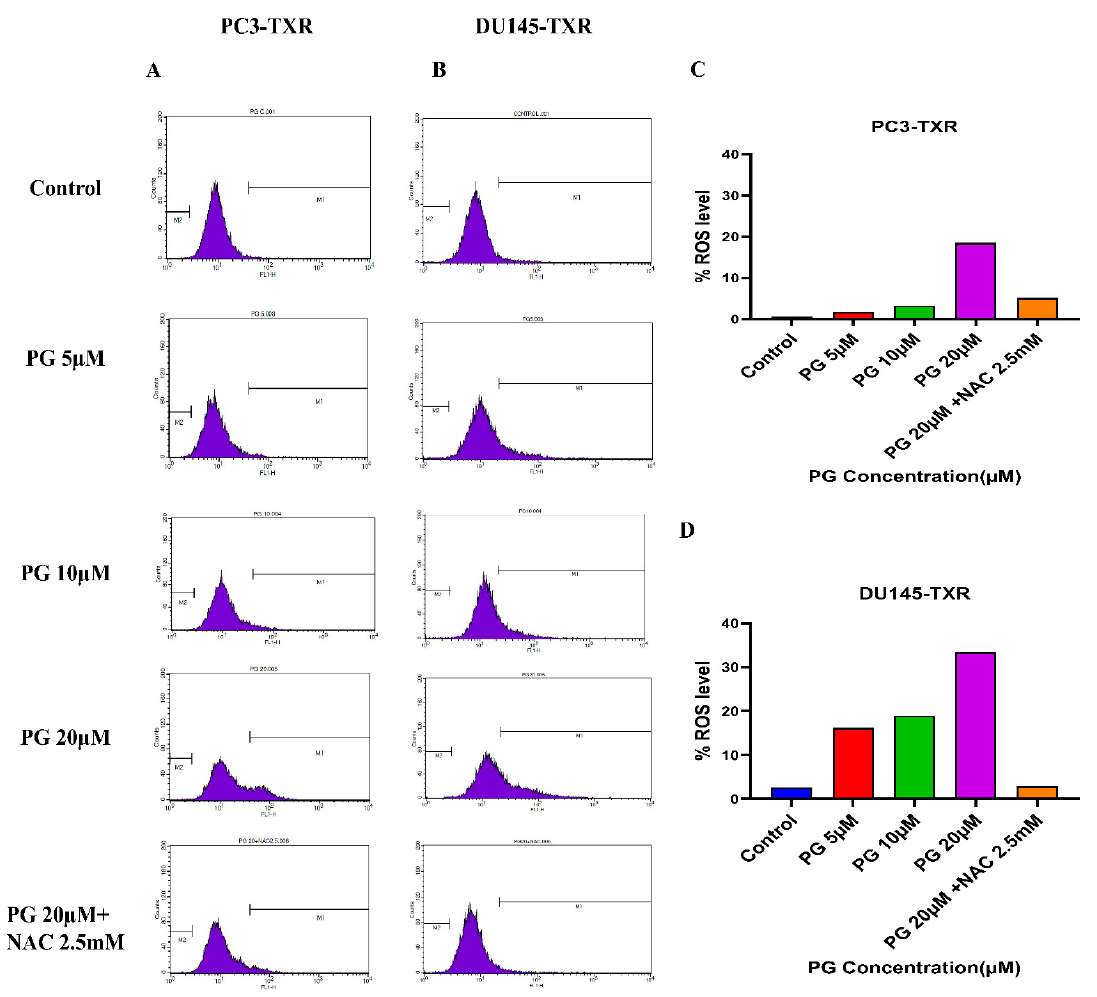
Figure 11. PG induces ROS production, resulting in oxidative stress in CRPC cells. PC3-TXR and DU145-TXR cells were stained with DCFH2-DA and then treated with different concentrations